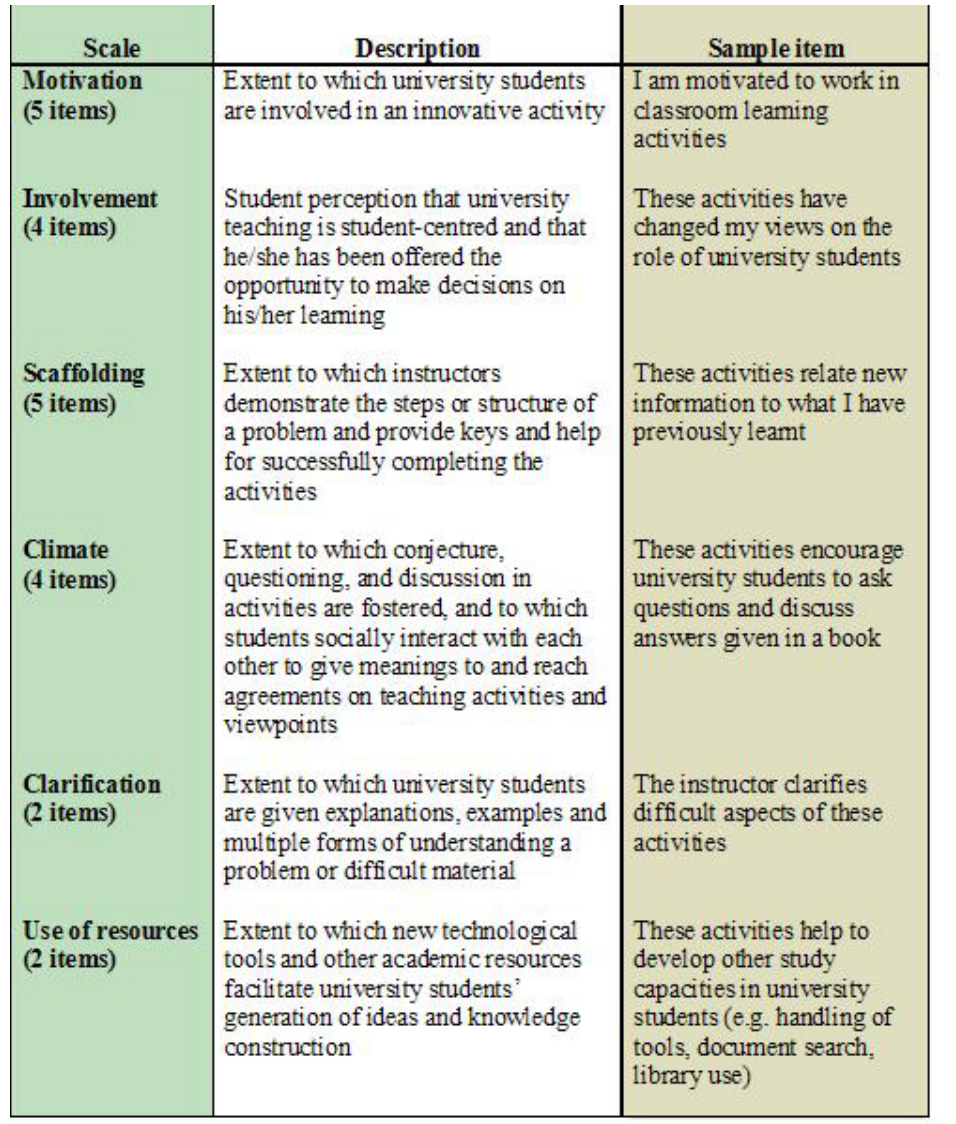
Table 2. Description of Scales and a Sample Item for Each Scale of the